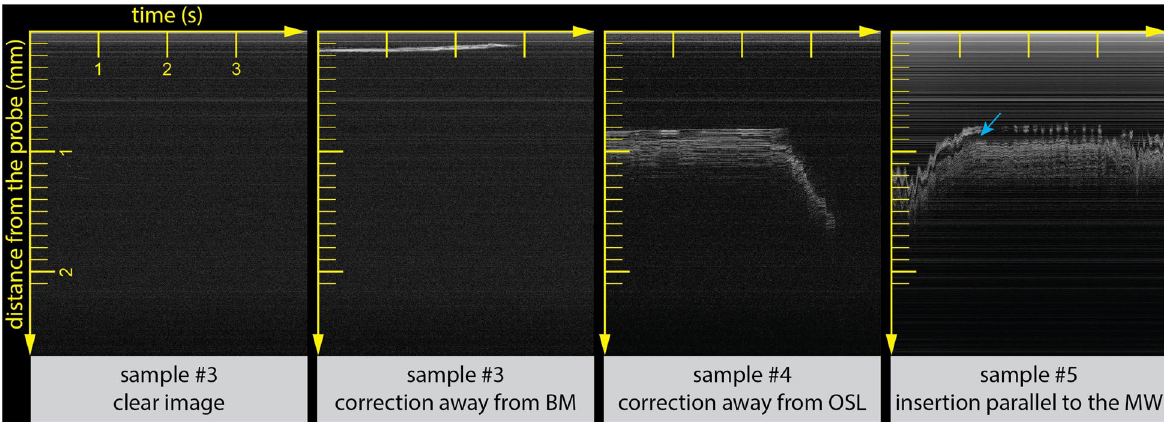
Figure 3. OCT-guided correction of insertion trajectory. (left) Example of a clear image, indicating a perfect insertion trajectory with no obstacles ahead for the imaging depth of the OCT probe. (middle left) Insertion parallel to the BM at a very close distance, followed by correction of the insertion trajectory, resulting in absence of visualized obstacles ahead of the optically-guided sheath. (middle right) Insertion parallel to the OSL at a relatively safe distance, followed by correction of the insertion trajectory (right side of image), resulting in increased distance and subsequent absence of visualized obstacles. (right) Insertion parallel to the MW at a relatively safe distance. Blue arrow indicates a large non-bony gap, presumably corresponding to the Rosenthal’s canal within the MW, which contains the auditory nerves. Horizontal and vertical axis are in correspondence with Fig. 2. BM basilar membrane; MW modiolar wall, OSL osseous spiral